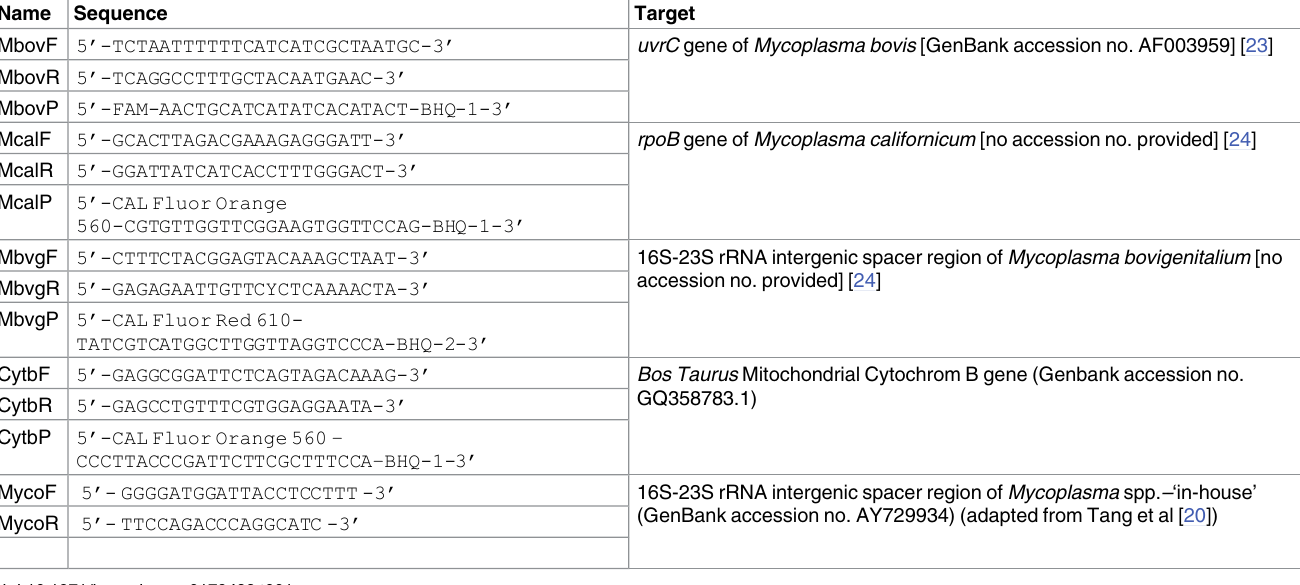
Table 1. Primer and probe sequences used for multiplex probe PCR and culture speciation [28]. Name